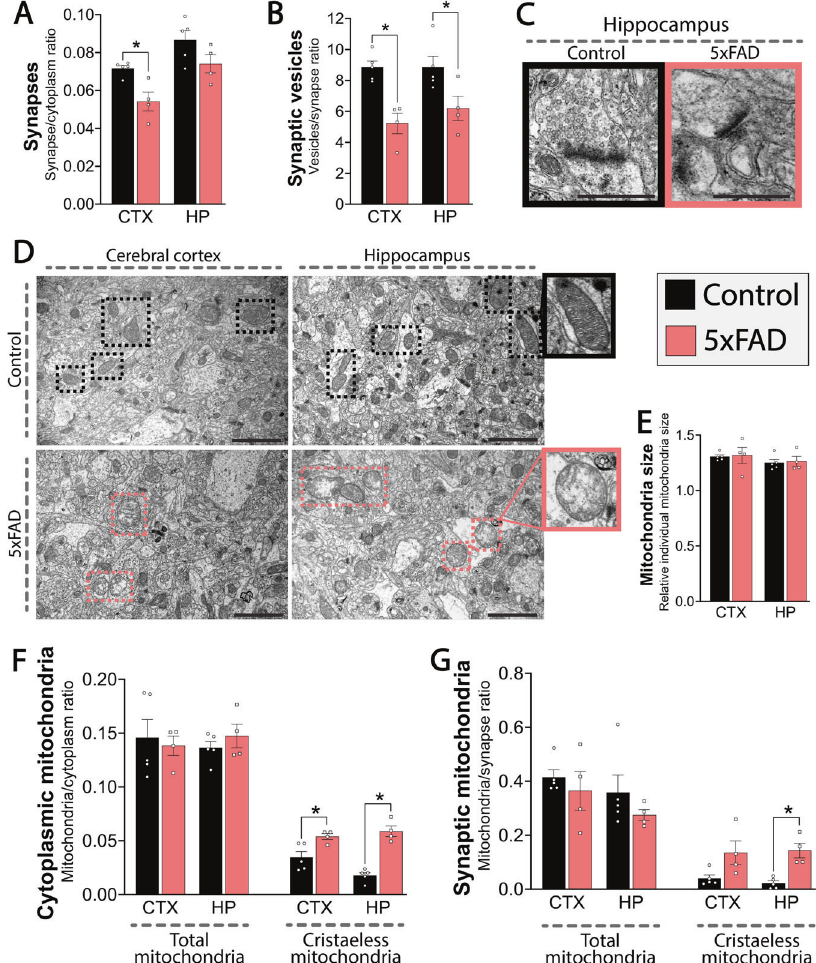
Fig. 7 Synaptic and mitochondrial changes in the 5xFAD brain. Ultrastructural analyses by transmission electron microscopy (TEM) evaluating mitochondria, synapses, and synaptic vesicles in fi xated cerebral cortical and hippocampal tissues of 4 months old 5xFAD mice. A Number of synapses relative to cytoplasm. B Number of vesicles per synapse. C Representative images of hippocampal synapses of control and 5xFAD. Scale bars: 2 µm. D Representative images of mitochondrial abundance and structure in cerebral cortex and hippocampus of control and 5xFAD mice. Scale bars: 2 µm. E Relative mitochondrial size. F , G Analysis of cytosolic ( F ) and synaptic ( G ) mitochondria. Both number of total and number of cristaeless mitochondria were assessed relative to cytoplasm ( F ) or synapses ( G ). CTX: cerebral cortex,